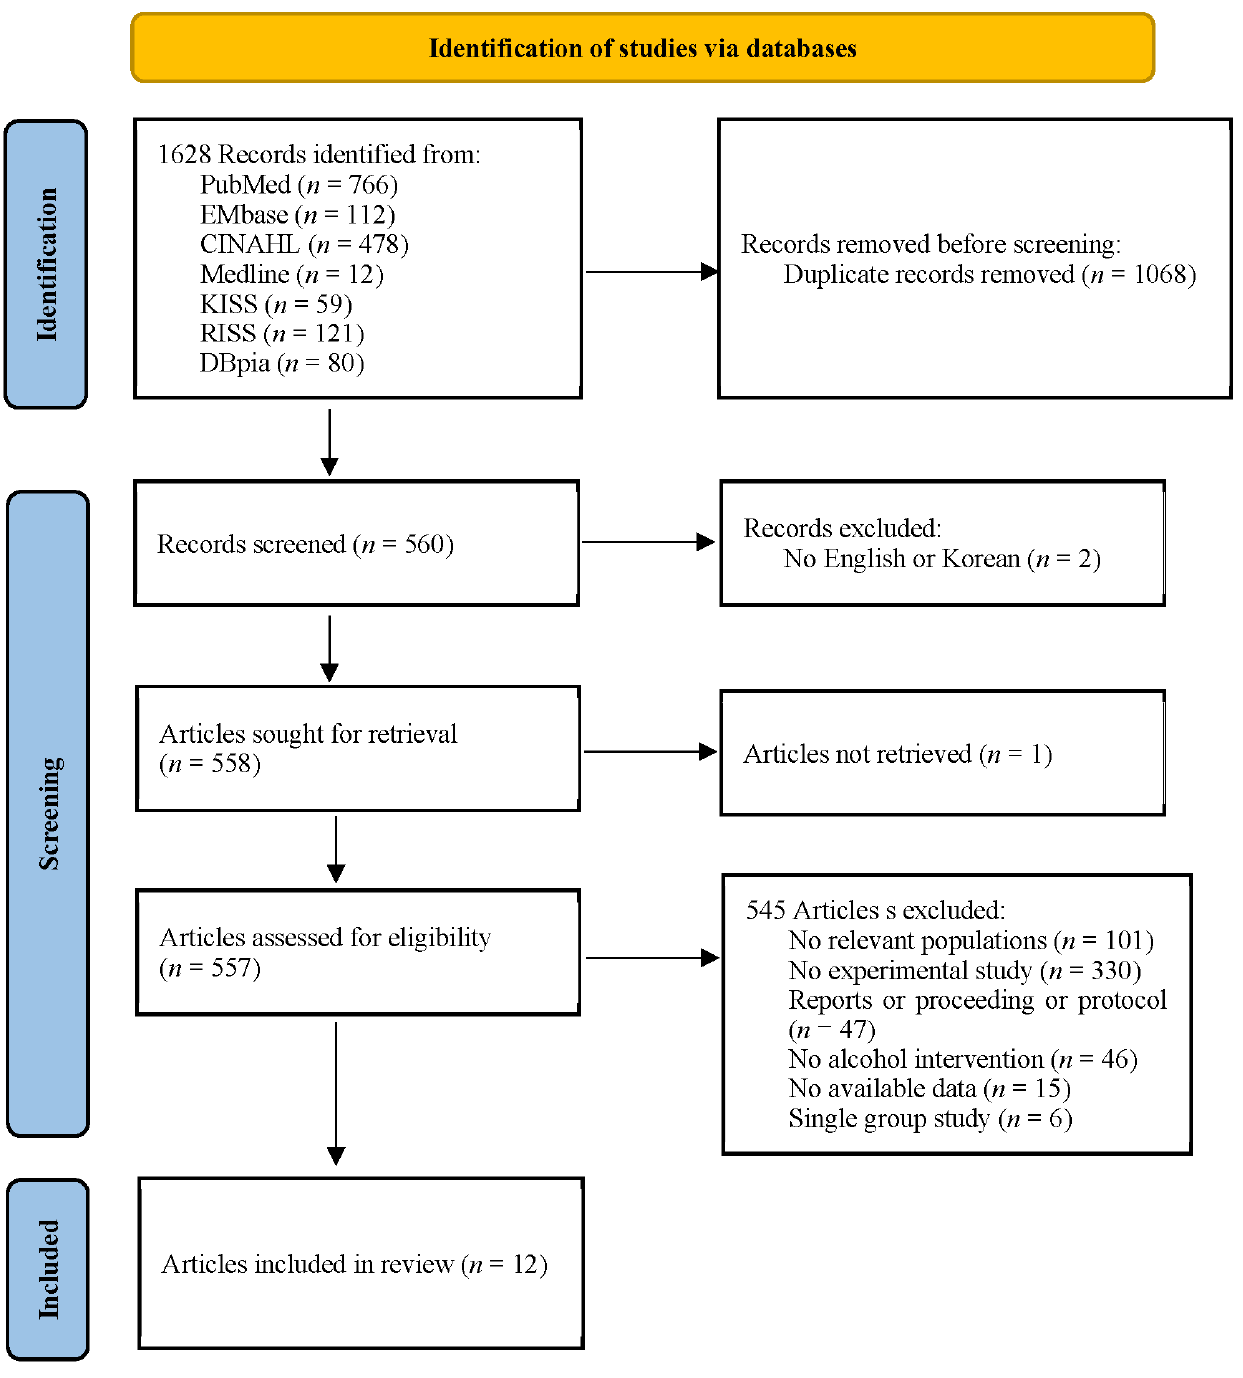
Figure 1. Diagram of the extraction flow.